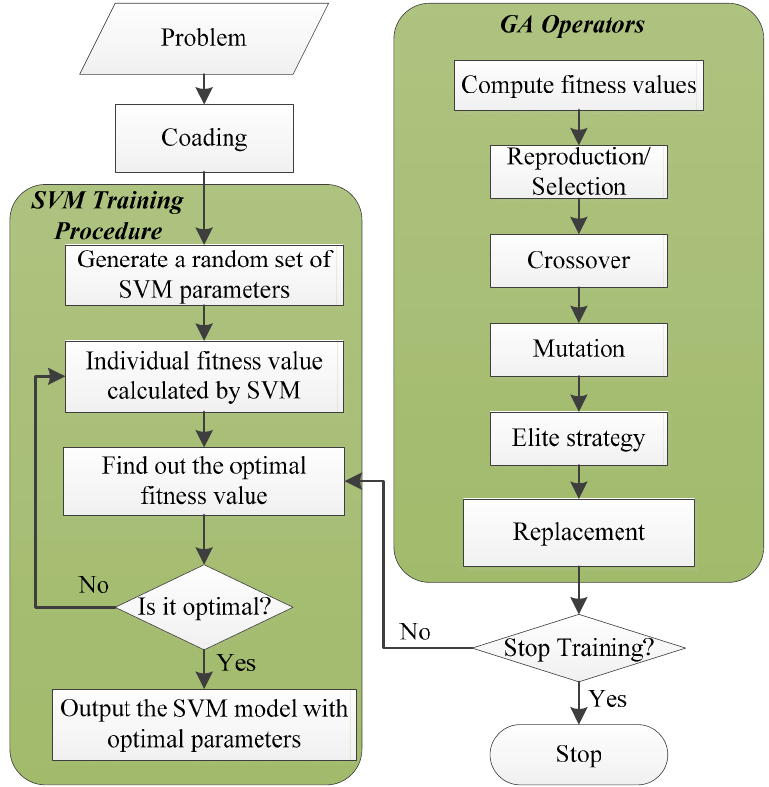
Figure 5. Framework of GA-SVM model.